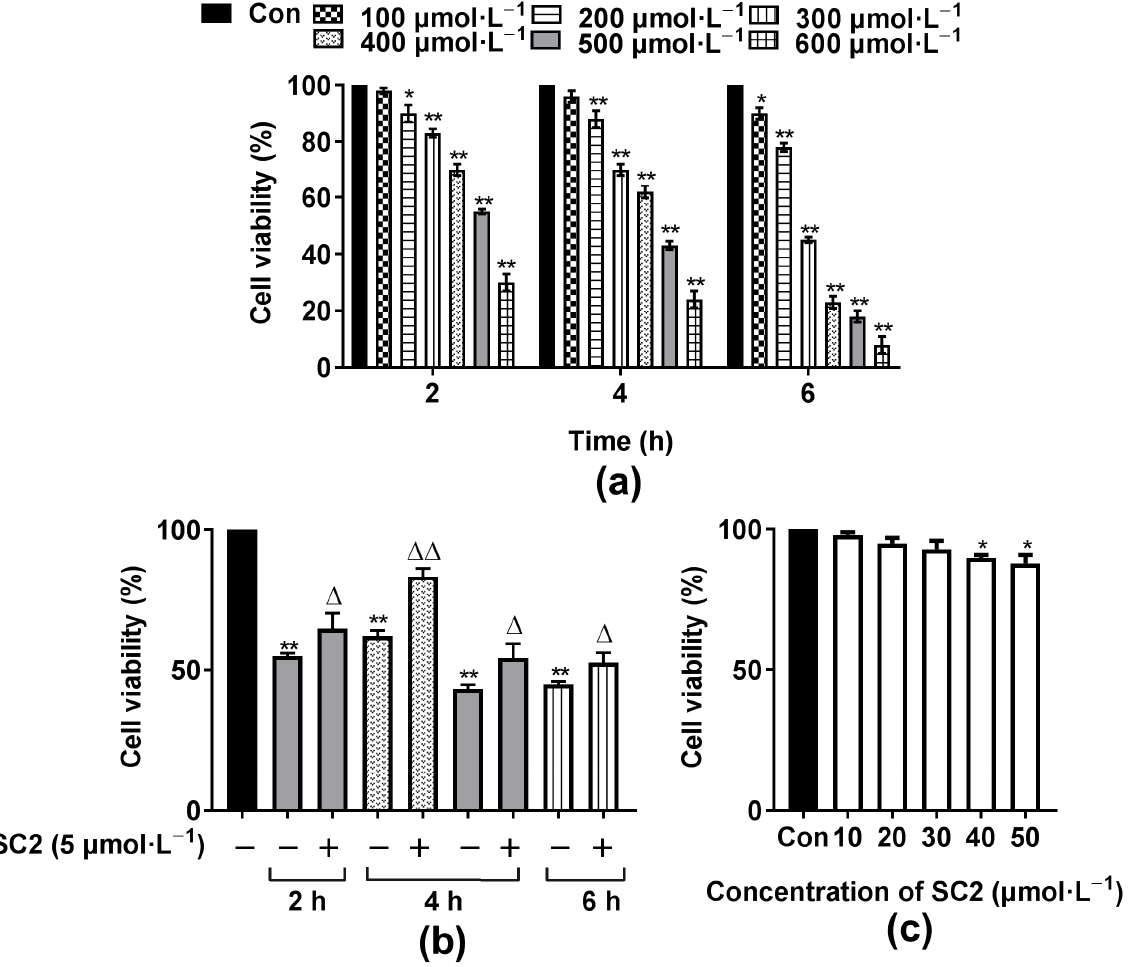
Figure 8. ( a ) Cell viability after exposure to 100, 200, 300, 400, 500 or 600 μ mol ∙ L − 1 H 2 O 2 for different durations ; ( b ) Cell viability after exposure to 5 μ mol ∙ L − 1 SC2 and various concentrations of H 2 O 2 for different durations; ( c ) Cytotoxocity of compound SC2 (compared with the control group, * p < 0.05, ** p < 0.01; compared with the model group, △ p < 0.05, △△ p < 0.01).